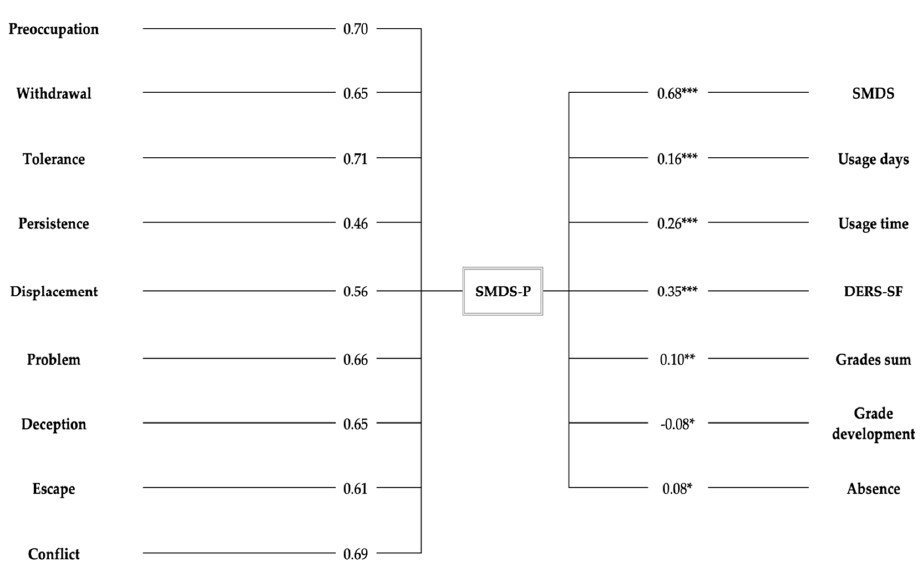
Figure 1. Factor loadings of the SMDS-P items on single factor and correlations with external criteria. Notes : Significant EFA SMDS-P item factor loadings are presented on the left side. Correlation coefficients with variables used to ascertain criterion validity are presented on the right side. All correlations were significant based on their p values with *** p ≤ 0.001, ** p ≤ 0.01, and * p ≤ 0.05. EFA = explanatory factor analysis, SMDS-P = Social Media Disorder Scale-Parental Version, SMDS